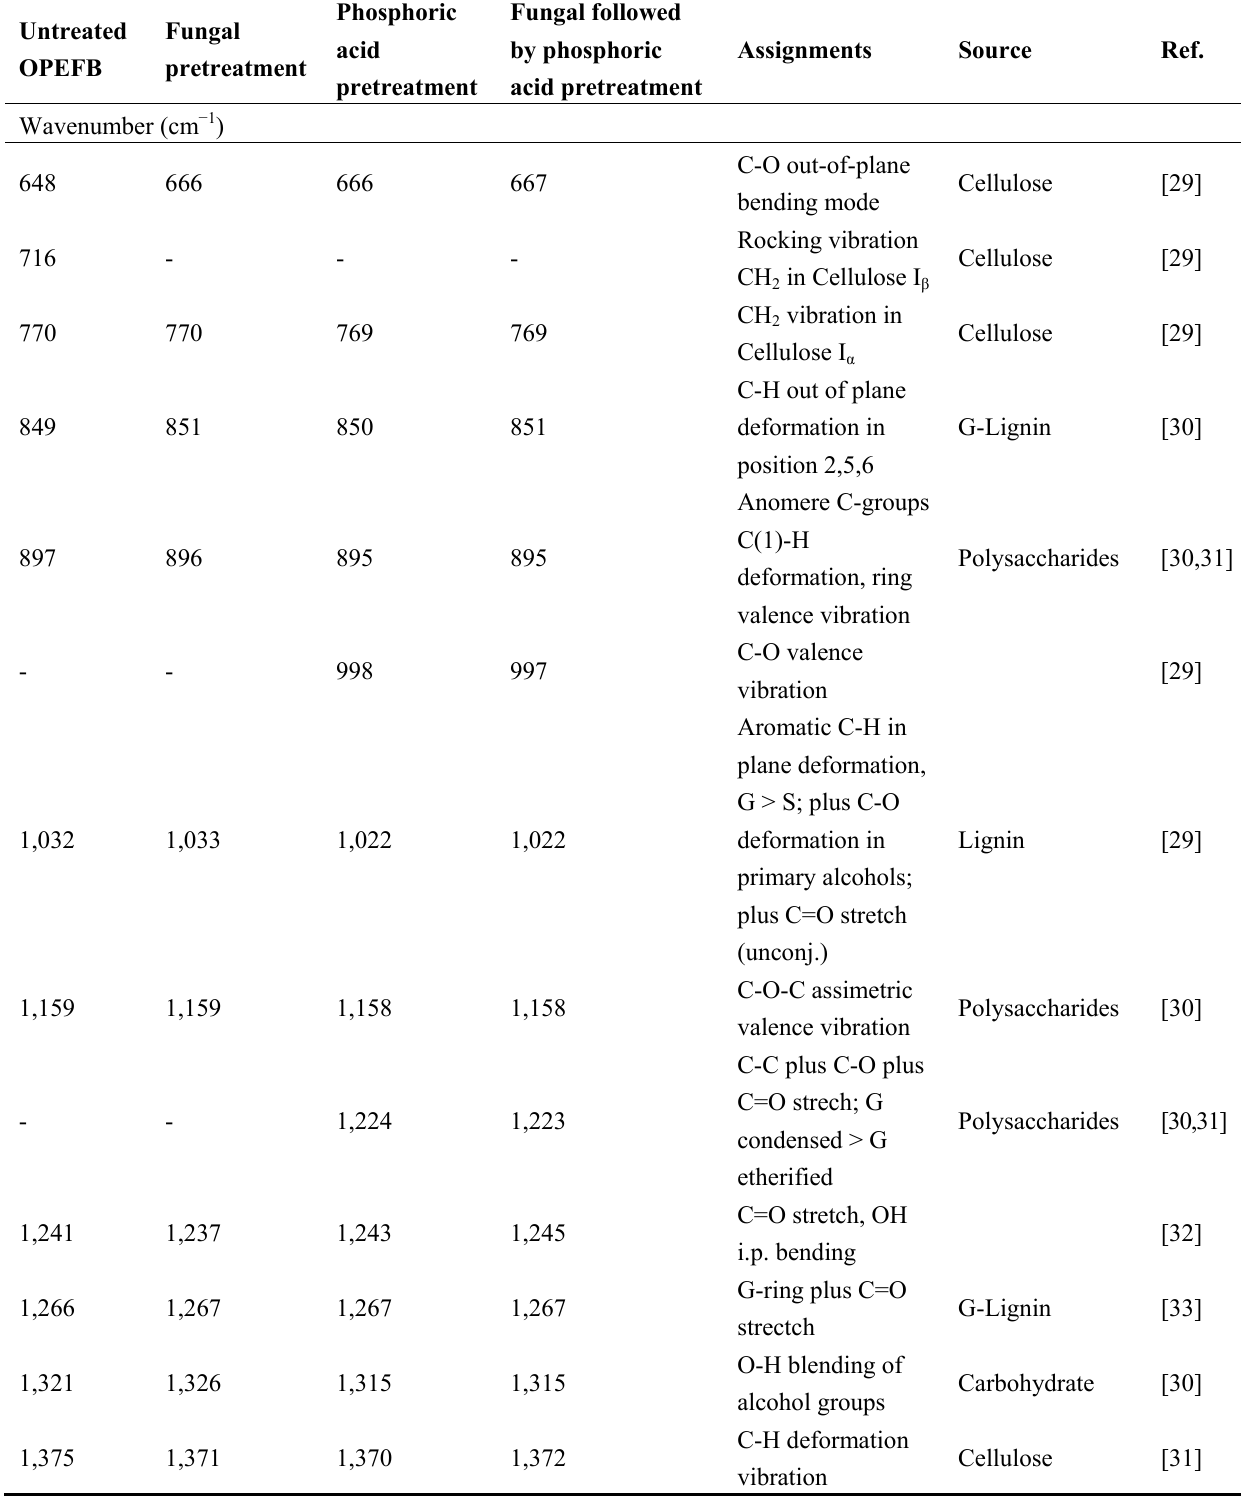
Table 3. Assignments of IR band maxima to various components of oil palm empty fruit bunches according to literature. Fungal followed Assignments Source